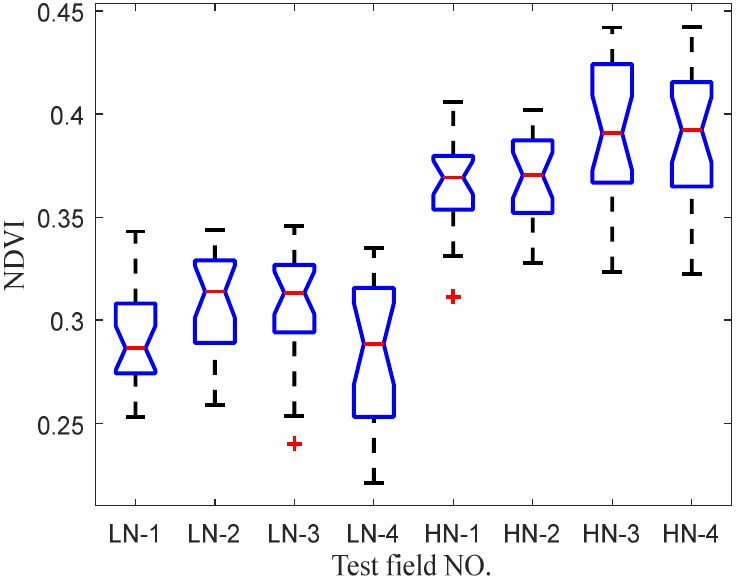
Sensors 2020 , 20 , 1830 Figure 17. Boxplot of NDVI values in test fields with different nitrogen application rate levels. Figure 17. Boxplot of NDVI values in test fields with di ff erent nitrogen application rate levels.